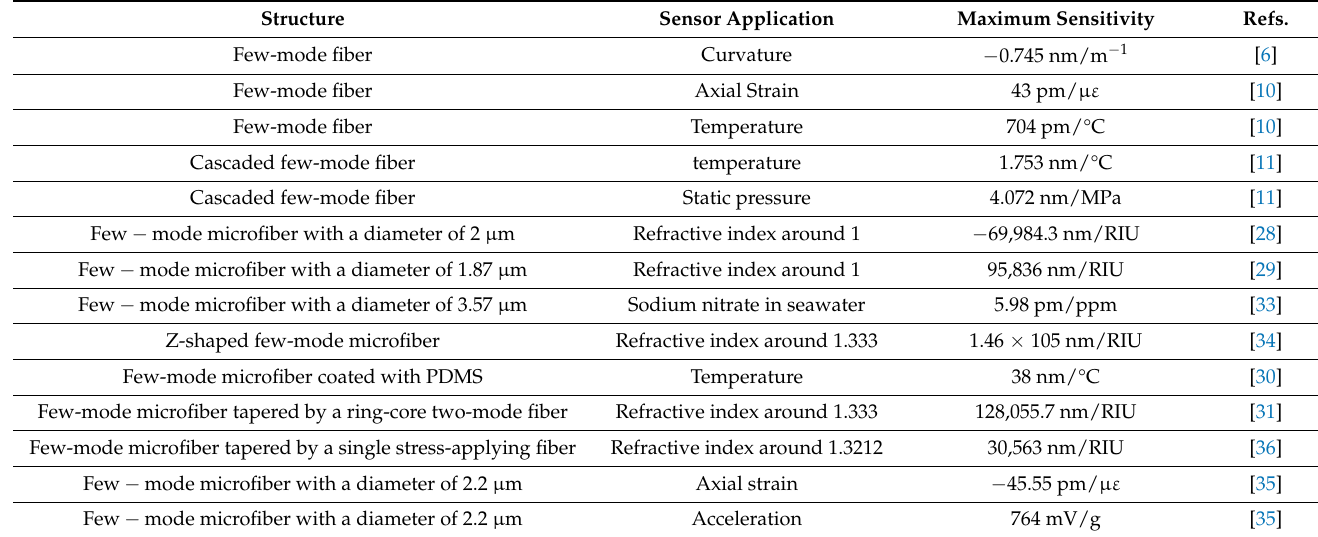
Table 1. Performance comparisons of different CWL-existed in-line MZI